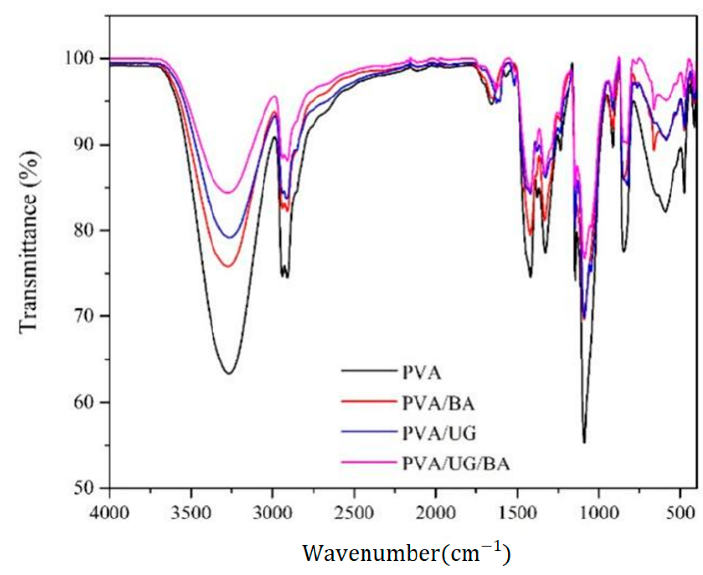
Figure 3. FTIR of PVA and the blend